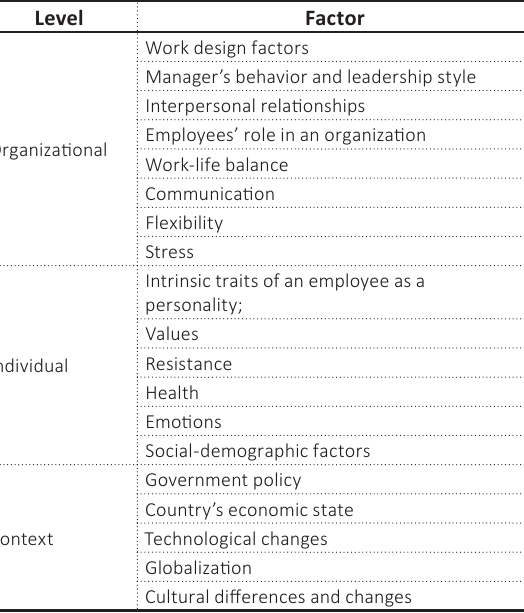
Table 1. Factors ensuring employee